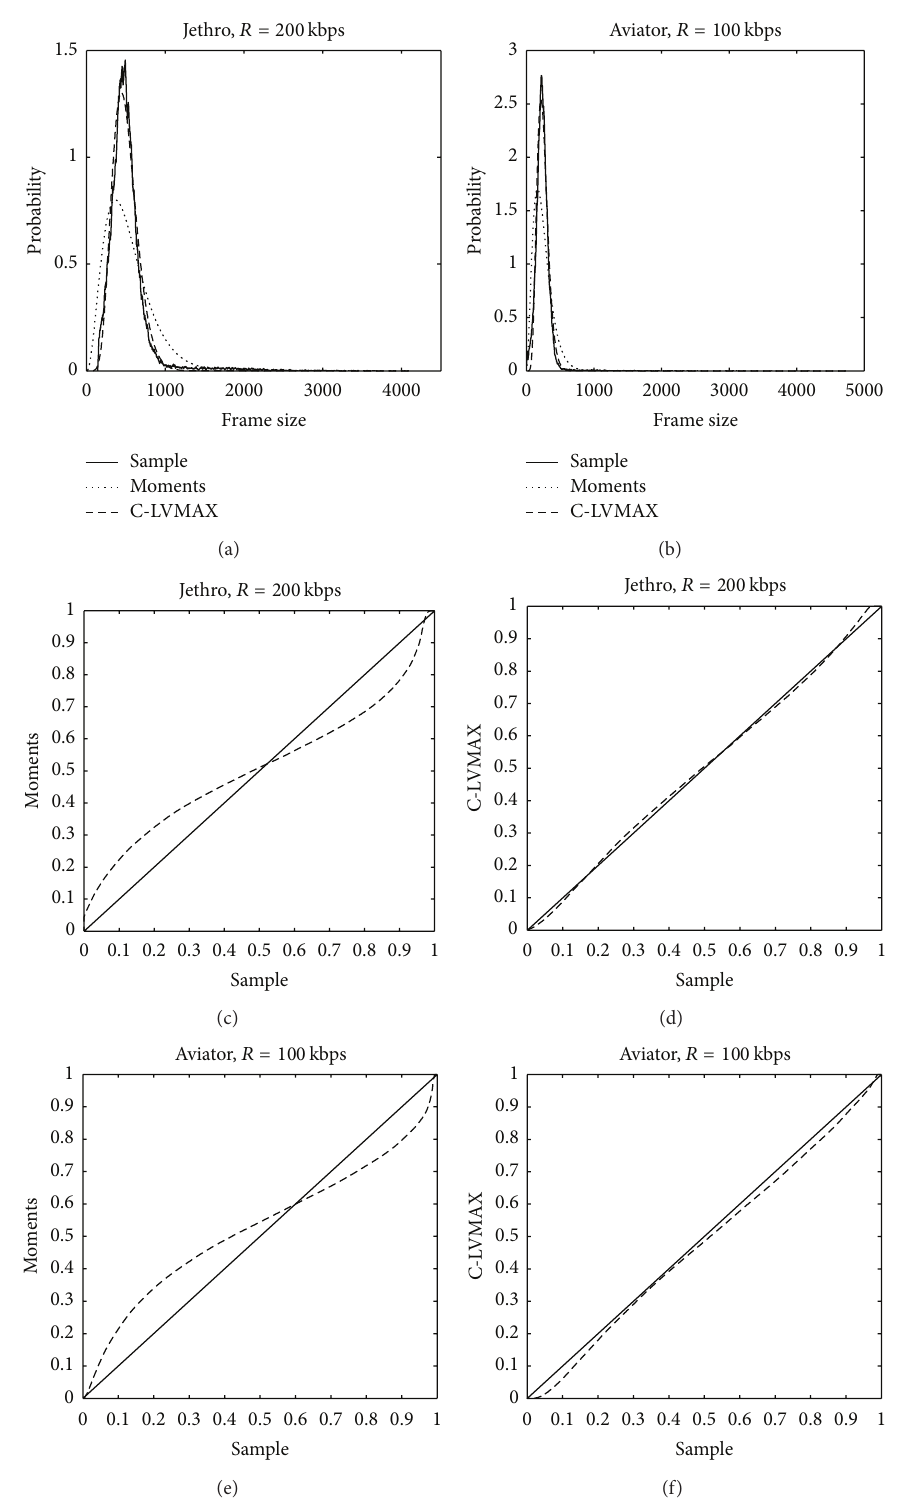
Figure 6: Constrained traffic, frame-size histograms, and q - q plots of moments matching